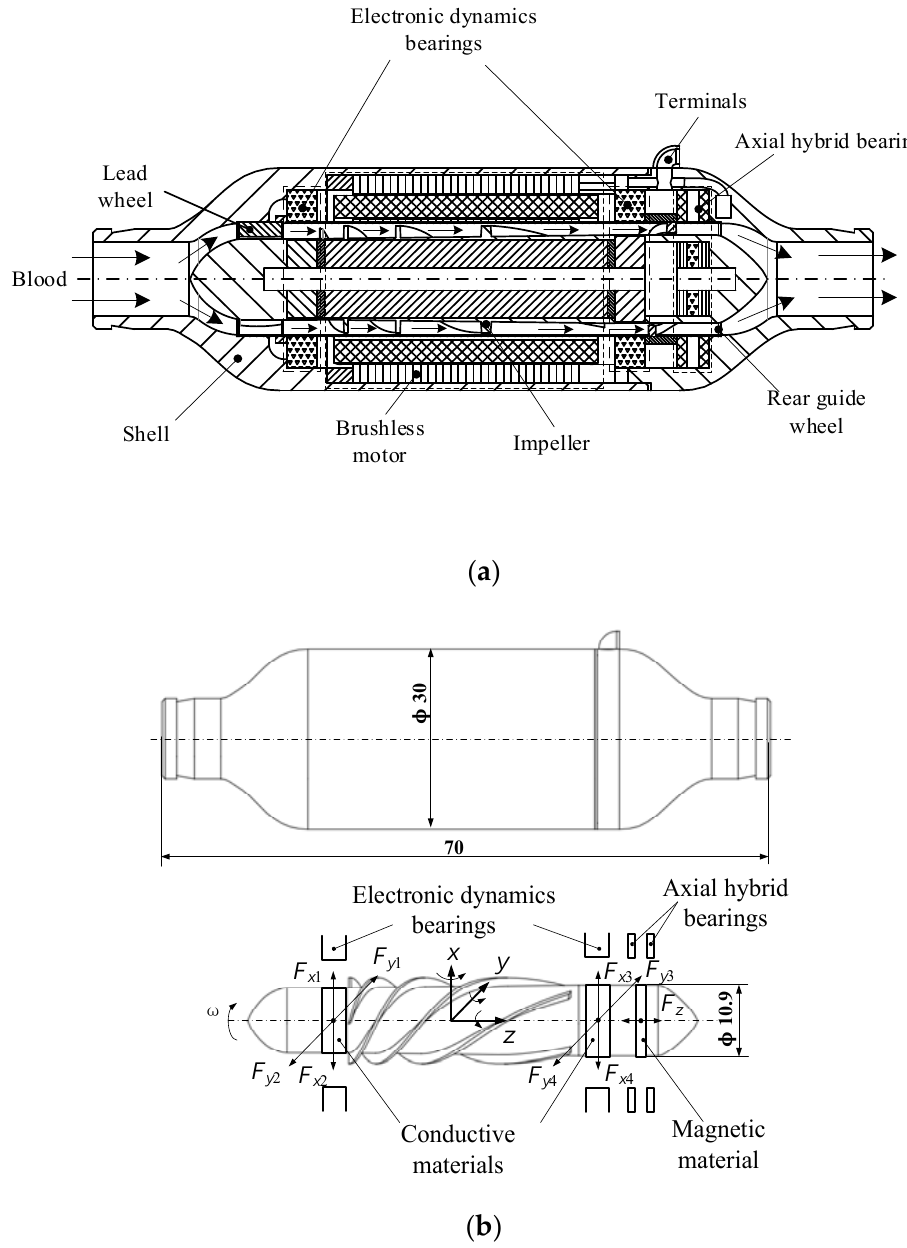
Figure 1. ( a ) Structure of the conical spiral axial blood pump and three-dimensional model. ( b ) Di- mensions and five-degree-of-freedom levitation of the axial blood pump and rotor.